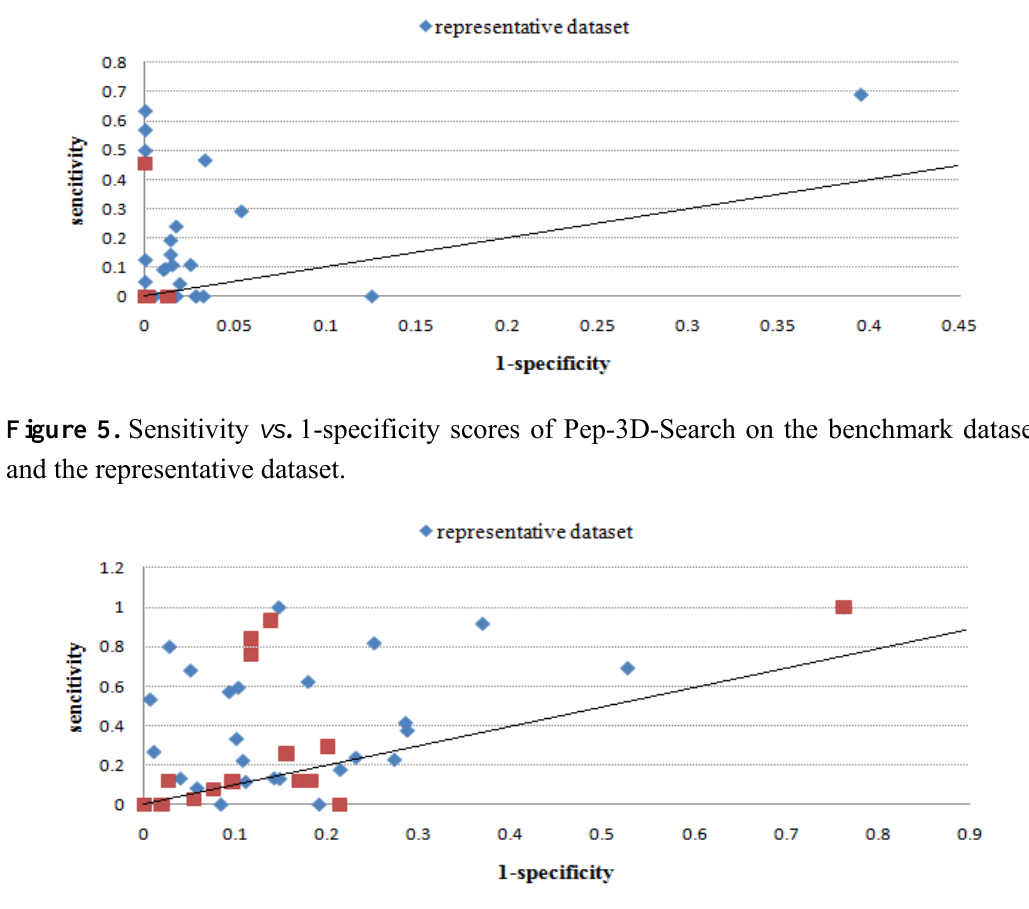
Figure 4. Sensitivity vs. 1-specificity scores of Pepitope on the benchmark dataset and the representative dataset.